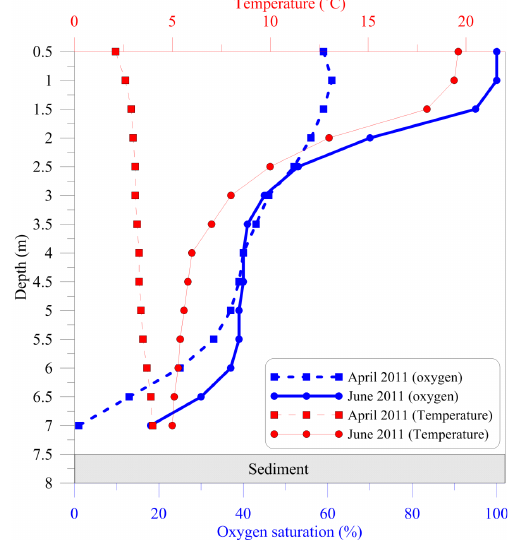
Fig. 1. Temperature and dissolved oxygen saturation profiles of Lill- sjön Lake in April and June